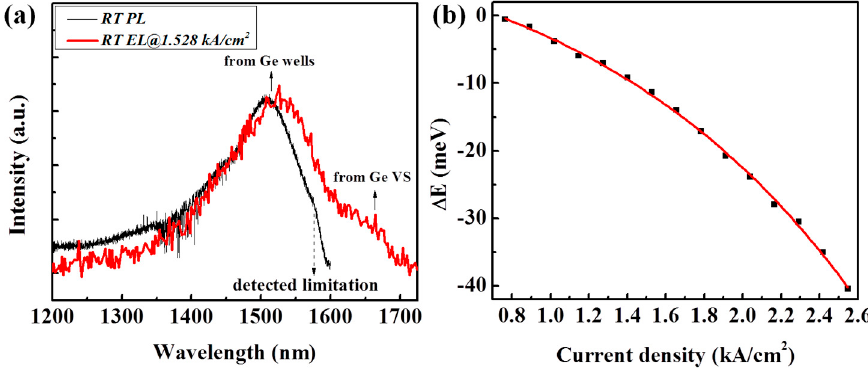
Figure 5. ( a ) Comparison of room temperature photoluminescence (PL) spectrum and EL spectrum under an injection current density of 1.528 kA/cm 2 ; ( b ) Reduction of peak energy ( ∆ E ) for EL spectra versus the injection current density ( J ) fitted by ∆ E ∼ J 2.52 .